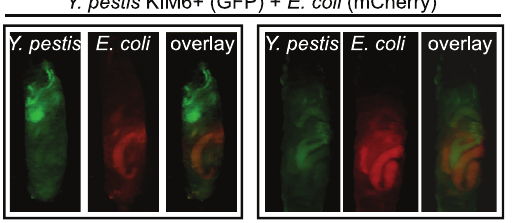
Fig 3. Localization of Y . pestis to the midgut is specific. Larvae were coinfected with ~5x10 8 CFU each of KIM6+ strain expressing GFP (green) and E . coli containing mCherry (red). Larvae were imaged using fluorescence microscopy to detect both GFP and mCherry and images from both fluorescent channels were overlaid. Representative images from two trials are shown (n = 15